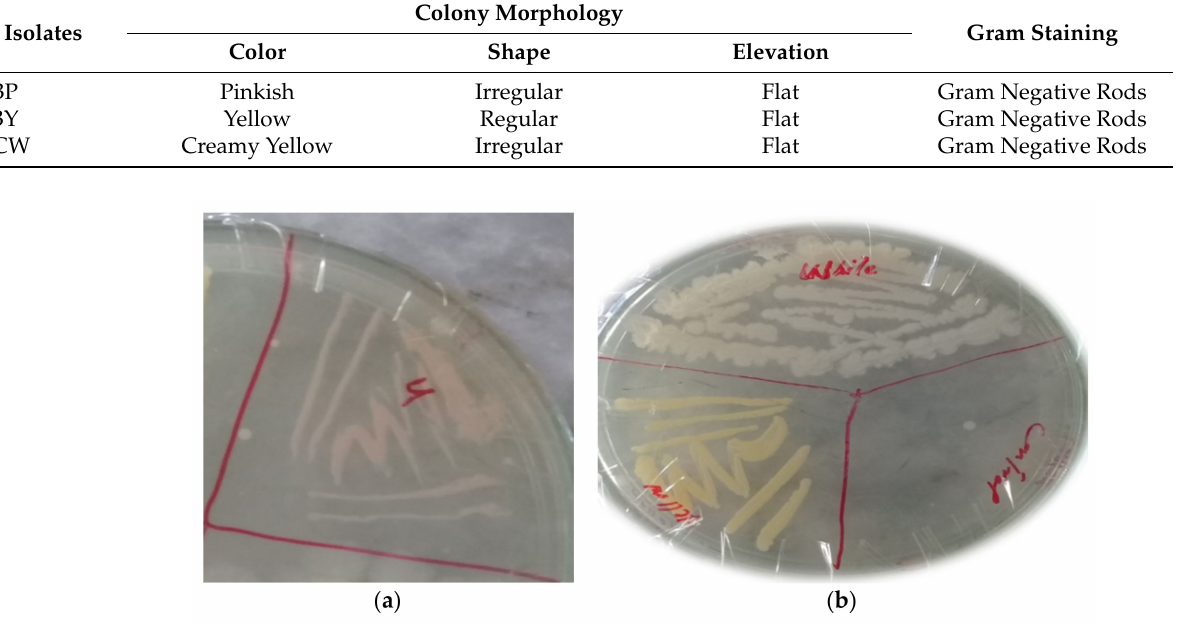
Figure 3. ( a ) Bacterial Isolate ABP colony; ( b ) bacterial Isolate ABY and ABCW colony.